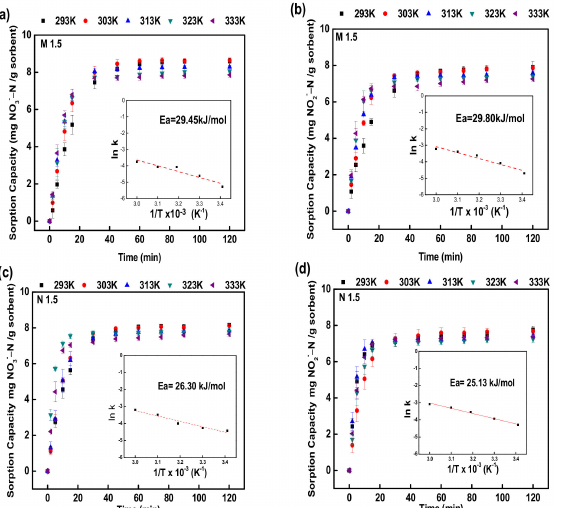
Figure 6. Adsorption capacities of nitrate and nitrite through M 1.5 and N 1.5 at different temperature. Adsorption capacity of nitrate ( a ) M 1.5 and ( c ) N 1.5; Adsorption capacities of nitrite ( b ) M 1.5 and ( d ) N 1.5. The inserted figures were fitting curves for activation energy of adsorption energy. Initial concentration of nitrate/nitrite was 50 mg N/L, adsorbent dose was 4 g/L, and pH = 5–6.